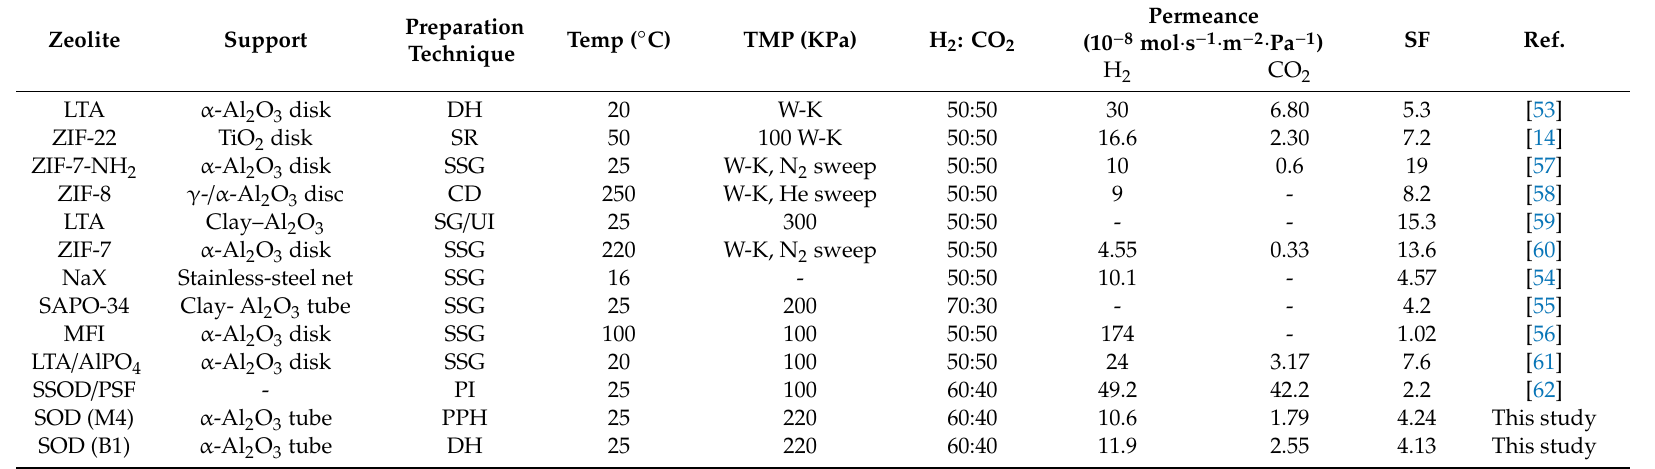
Table 2. Comparison of mixture gas separation data of the SOD membrane in this study with other membranes in the literature. W-K: Wicke–Kallenbach technique; DH: Direct hydrothermal; SR: Solvothermal Reaction; PI: Phase Inversion; SG / UI: Seeded Growth / Ultrasonic Irradiation; SSG: Secondary Seeded Growth; PPH: Pore-Plugging Hydrothermal; SSOD / PSF: Silica Sodalite / Polysulfone; SF: Separation